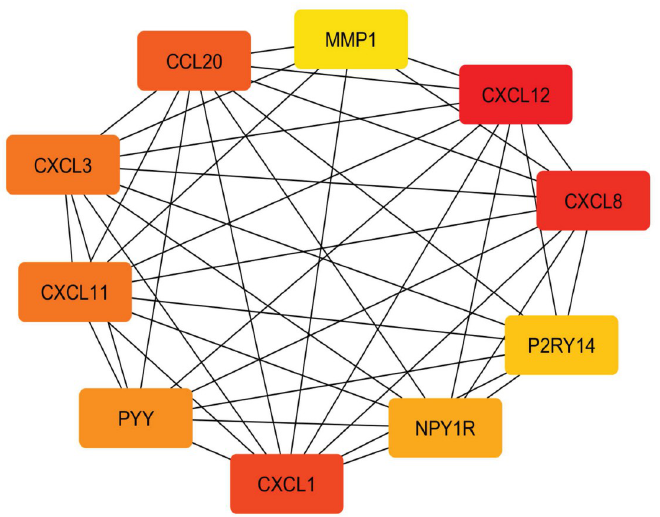
Fig 18. Protein protein interactions network connecting top-ten proteins based on the MCC criterion in the cyto hubba plugin.